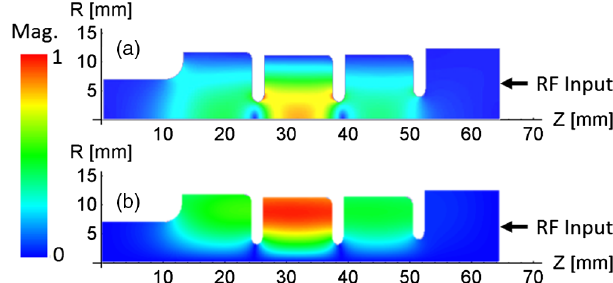
FIG. 2. Measurement (red) and linear model (blue) for two pulses with flat gradient section of 400 ns of low (left) and high (right) power at 45 K and 10 Hz. The input rf pulse (green), FIG. 1. Surface electric and magnetic fields for the cryogenic begins at 50 ns and ends at 600 ns. The model agrees with the cavity. The fields are scaled to 2.5 MW dissipated in the cavity, T ¼ 45 K and Q ¼ 30 , 263. (a) shows the surface electric fields, measured signal for Q 0 ¼ 30 , 263 at low power ((a) – (c)). For 0 with a maximum 400 MV = m. (b) shows the surface magnetic high power ((d) – (f)), the linear model does not match the fields, with a maximum 580 kA = m. measured rf and dark current